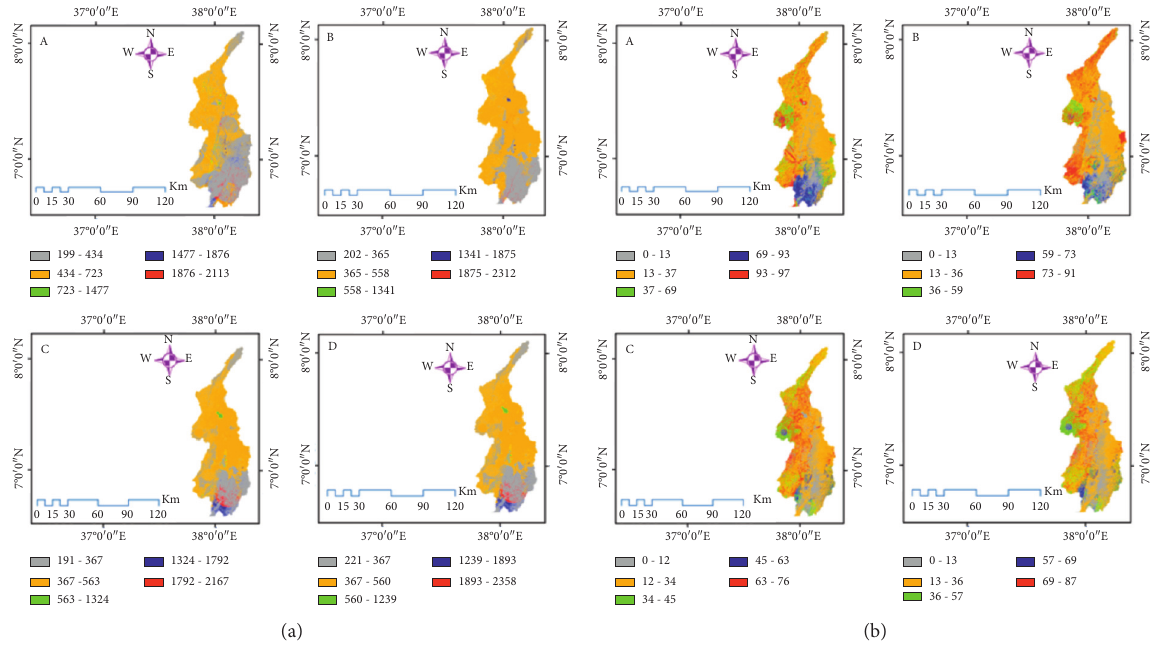
Figure 10: Maps of water balance components simulated with the WetSpass model (a) and (b) at each LULC classes of (A) 1989, (B) 1999, (C) 2009, and (D)